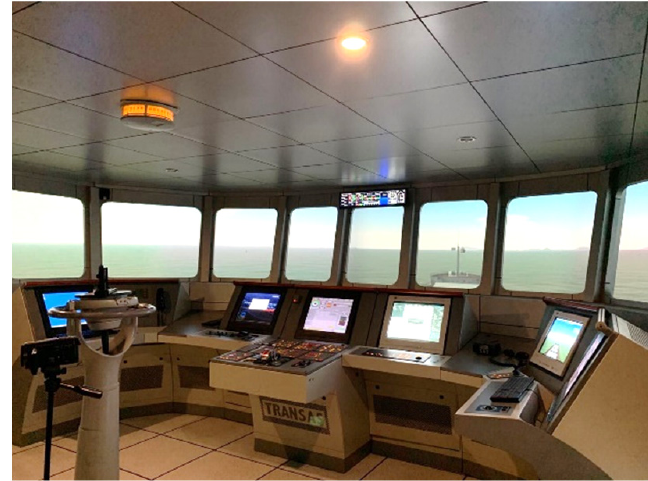
Figure 1. The bridge simulator room.